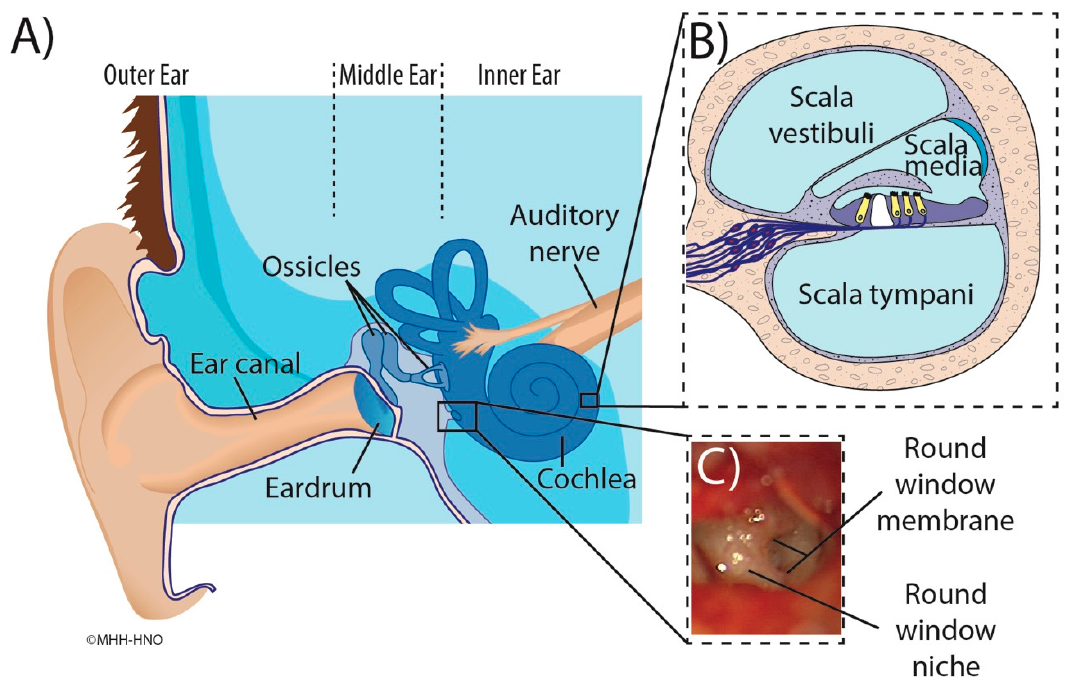
Figure 1. Illustration of the human ear anatomy. Main figure ( A ): Overview of the outer ear, ear canal and structures of the middle ear containing the tympanic membrane (eardrum), round window niche, and ossicles. The cochlea and auditory nerve are also shown. Inset ( B ): Cross-section of the cochlea illustrating the three fluids filled compartments scala vestibuli, scala media with sensory cells (yellow), and scala tympani. Inset ( C ): Intraoperative microscopic appearance of the round window region seen through facial recess with focus on the round window niche and round window membrane [15].